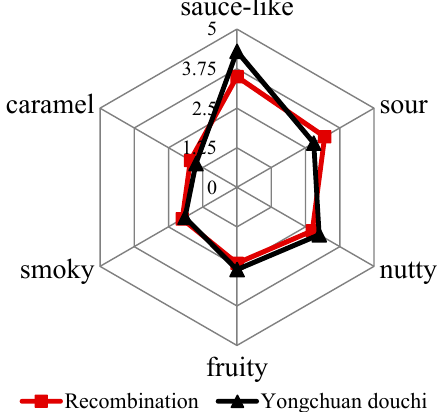
Figure 1. Aroma profile of Yongchuan douchi and recombinant model.